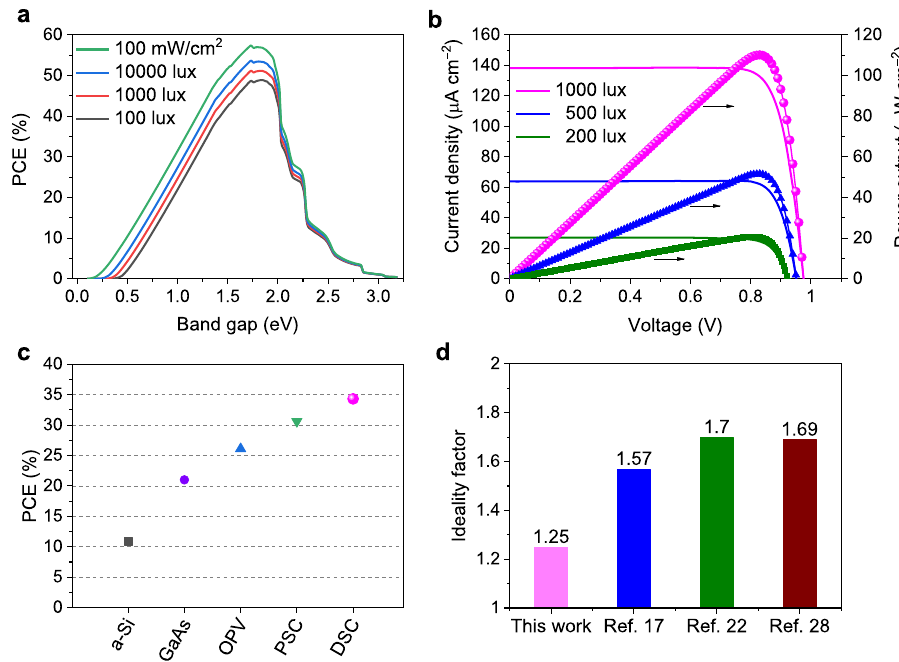
Fig. 5 The theoretical maximal PCE and the photovoltaic performance of MS5 + XY1b-based DSC under indoor lighting. a Band gap dependent simulations of the theoretical power conversion ef fi ciency (PCE) limitations (Shockley – Queisser limit) for different intensities of the model Osram 930 Warm White fl uorescent tube light. b Current density – voltage curves and power output of the dye-sensitized solar cell (DSC) with a photoactive area of 2.80 cm 2 under different ambient light intensities. c Summary of the best indoor PCEs of various types of solar cells with the photoactive area of at least 1 cm 2 , including amorphous silicon (a-Si), GaAs, organic polymers (OPV), metal halide perovskite (PSC), and DSC. d Summarized the ideality factors of representative publications on DSCs under ambient light. Table 2 Photovoltaic parameters of the DSC based on MS5 + XY1b with photoactive area of 2.80 cm 2 (length: 40 mm; width: 7 mm) under different light intensities from an Osram 930 Warm White fl uorescent